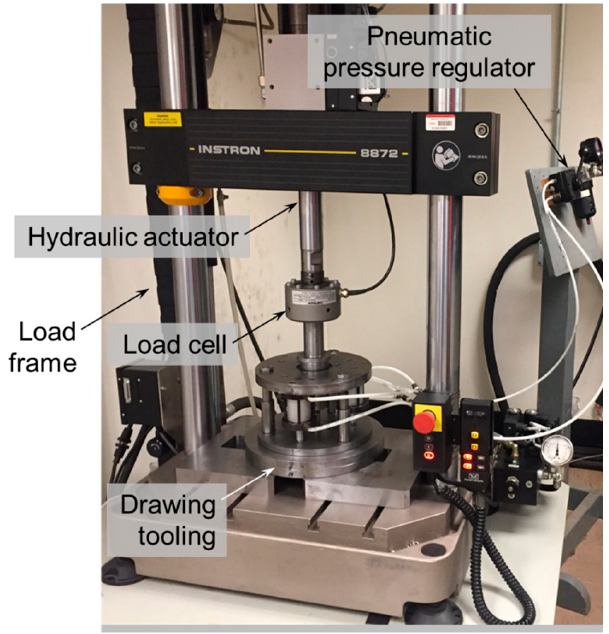
Figure 2. Experimental setup used for the deep-drawing of AA1100-O blanks.